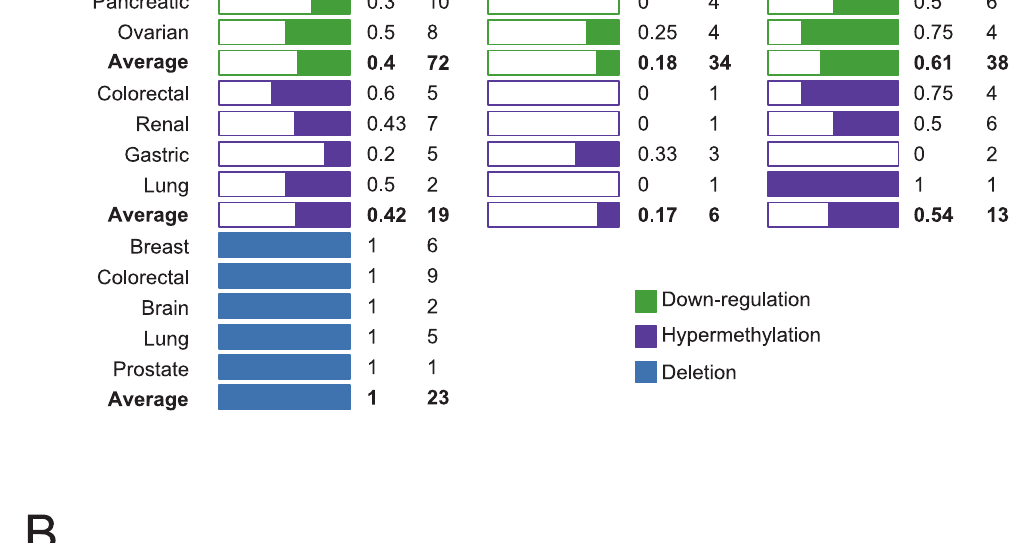
ATM for the colorectal cancer, CDKN2A-p16(INK4a) and BRCA1